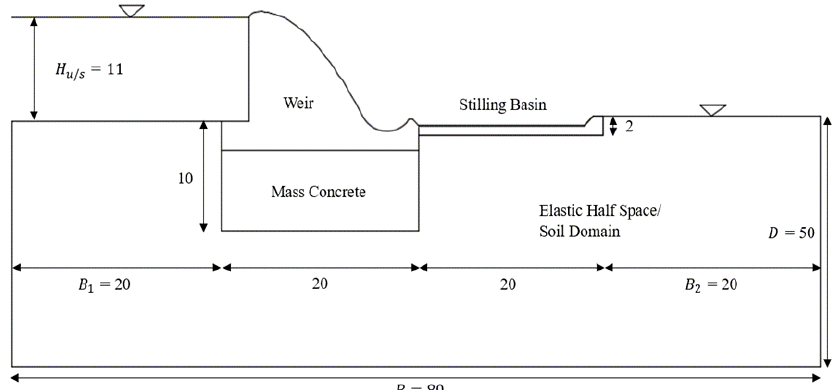
Fig. 1. Geometry and Dimensions (m) of the Weir structure foundation